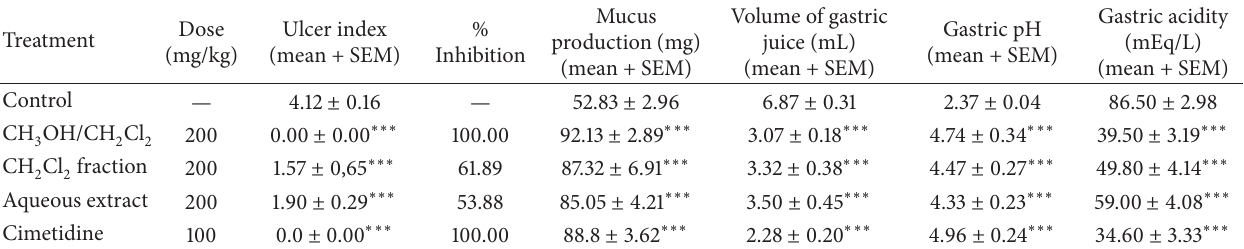
Table 3: Effects of orally administered E. speciosa on histamine-induced gastric ulcers and gastric secretion in rats. Treatment